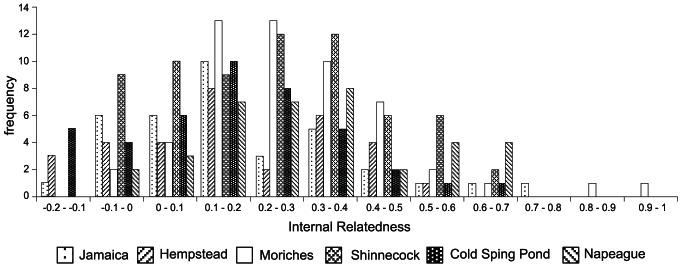
Internal relatedness.Frequency distribution of level of internal relatedness (IR) over all loci for all sample locations.